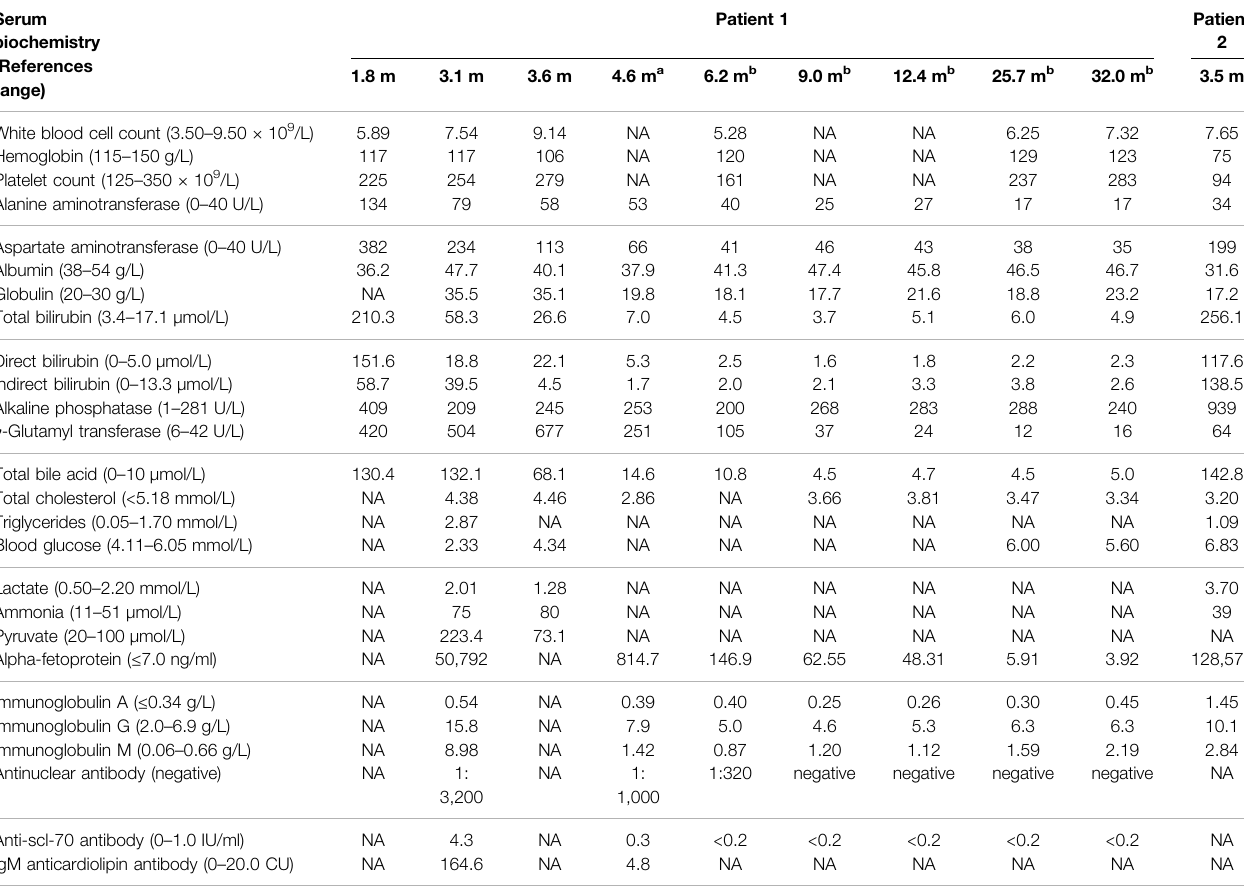
TABLE 1 | Results of blood examinations. Serum